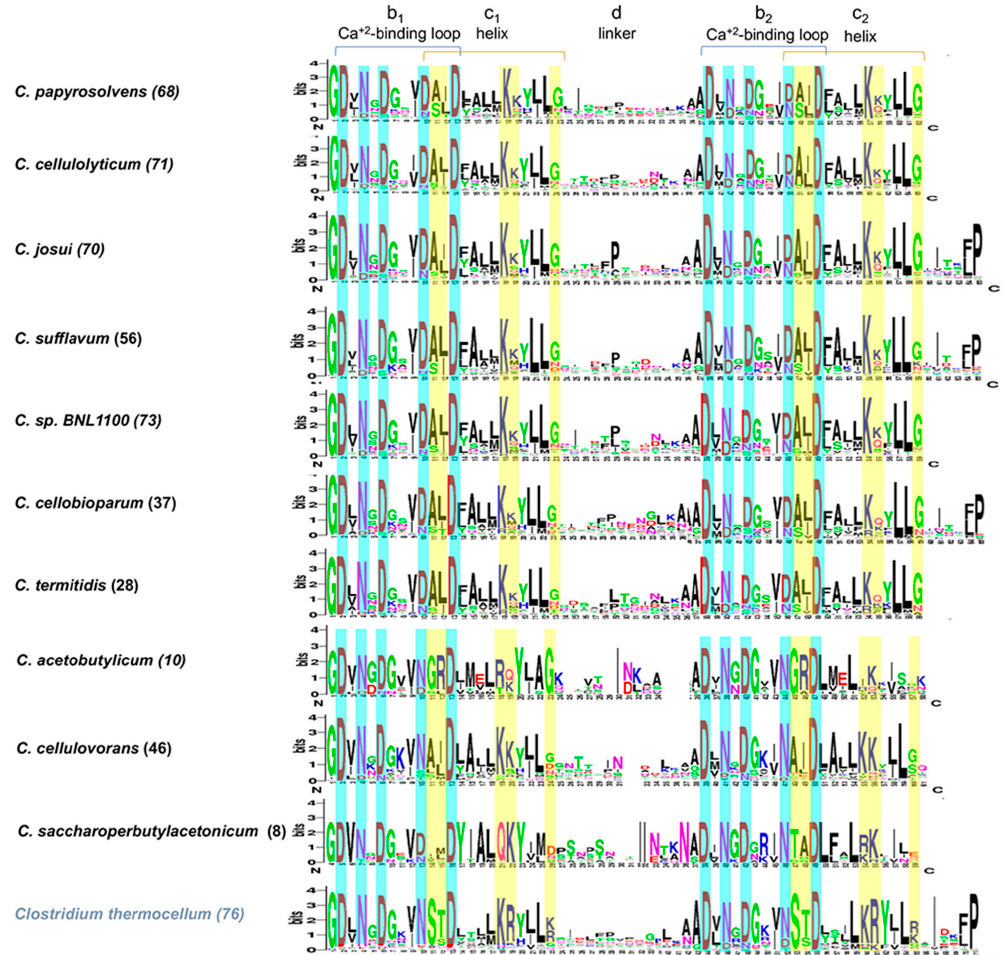
Figure 5. Conserved sequence features of dockerin modules in cellulolytic species. Aligned sequences of the dockerin module within each species were visualized by WebLogo. Similar profiles of dockerins were observed among the species, in particularly, the conservation of putative cohesin–dockerin binding positions at the Ca-binding loop (in yellow). Number of aligned sequences species is marked in brackets. Dockerin segments (b–d at top) are labelled according to Pagès et al. [39]. C. bornimense was omitted, because it contains only five sequences.